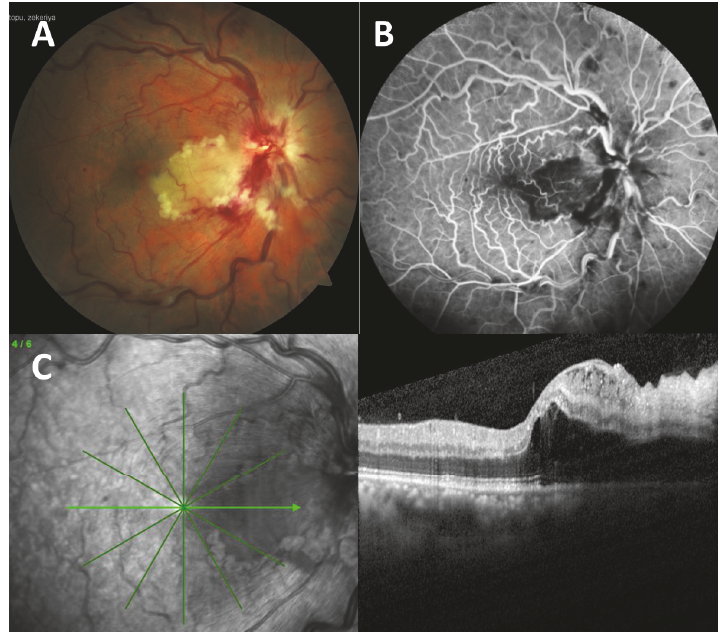
Figure 1: Color fundus photographs of the right eye (A) at the time of presentation. On fluorescein angiography (B), nonperfusion of the cilioretinal artery was shown in the area of cilioretinal at the initial presentation. Optical coherence tomography (OCT) at baseline (C)showed the presence of intraretinal and subretinal fluid and hyperreflective inner retinal